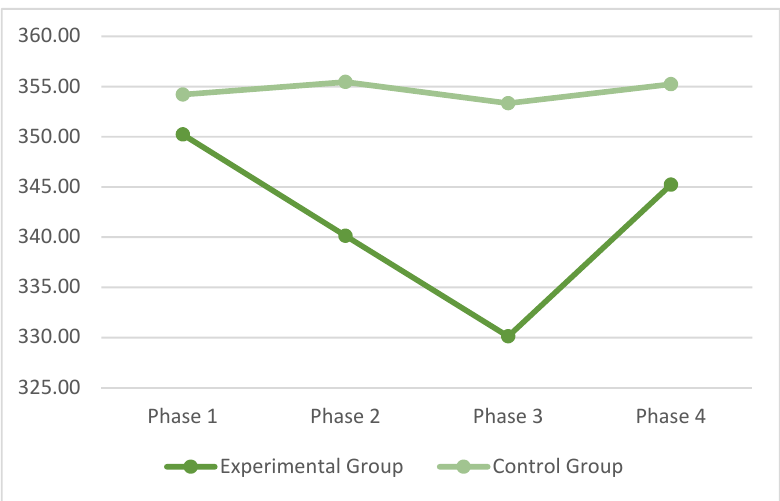
Figure 2. RT means in the four phases of the Visual Search Task .